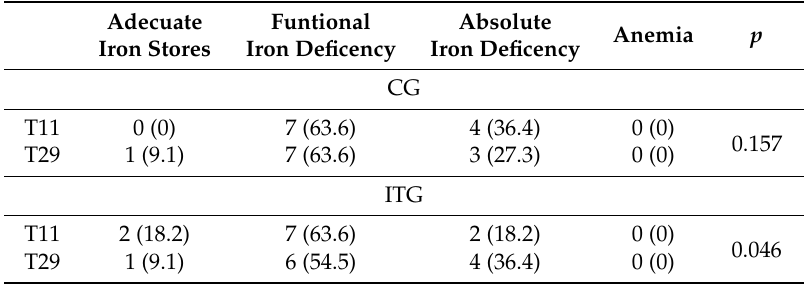
Table 1. Iron Categorization in control group (CG; n = 11) and iron treatment group (ITG; n = 11) at finish of iron treatment (T11) and at the finish of season